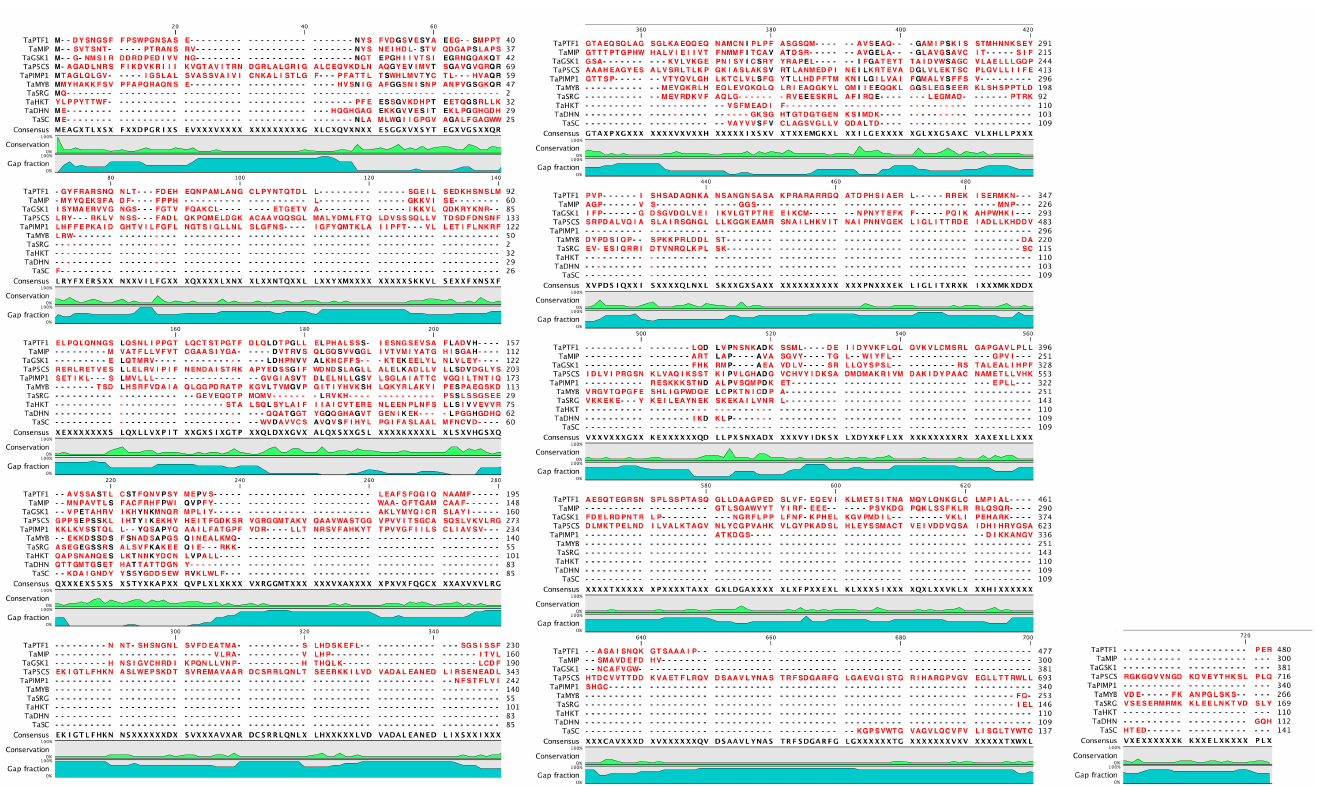
Figure A1. Amino acid alignment of TaPTF1 , TaDHN , TaSRG , TaSC , TaPIMP1 , TaMIP , TaHKT1;4 , TaGSK , TaP5CS , and TaMYB